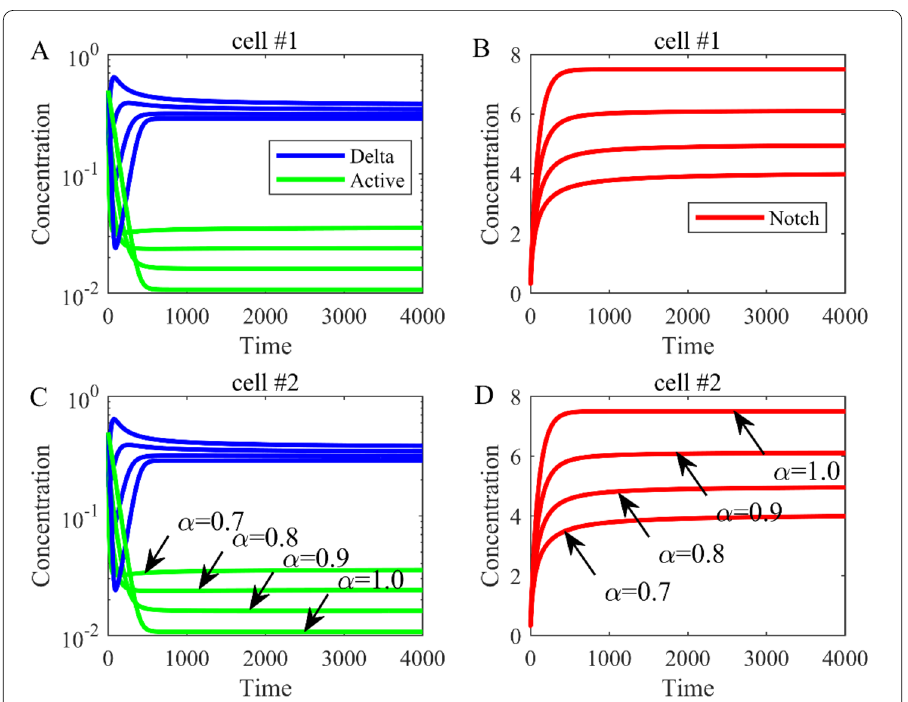
Figure 13 The dynamic between the fractional-order model and the integer-order model in two cells. ( A ) The dynamical trend of Delta and active Notch in cell 1. ( B ) The dynamical trend of Notch in cell 1. ( C ) The dynamical trend of Delta and active Notch in cell 2. ( D ) The dynamical trend of Notch in cell 2